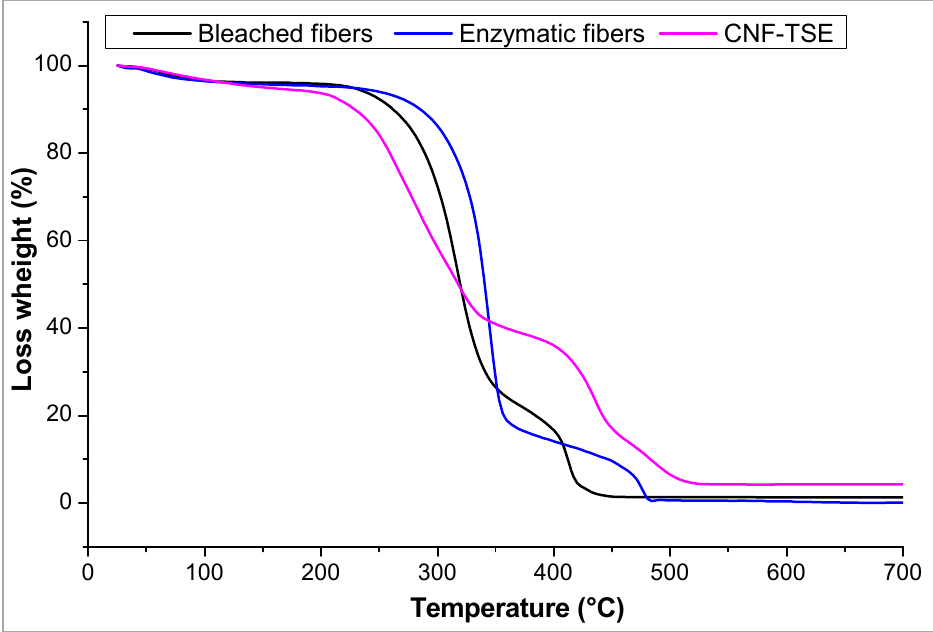
Figure 5. An example of the TGA profiles of the bleached fibers, enzymatic fibers, and CNF-TSE.